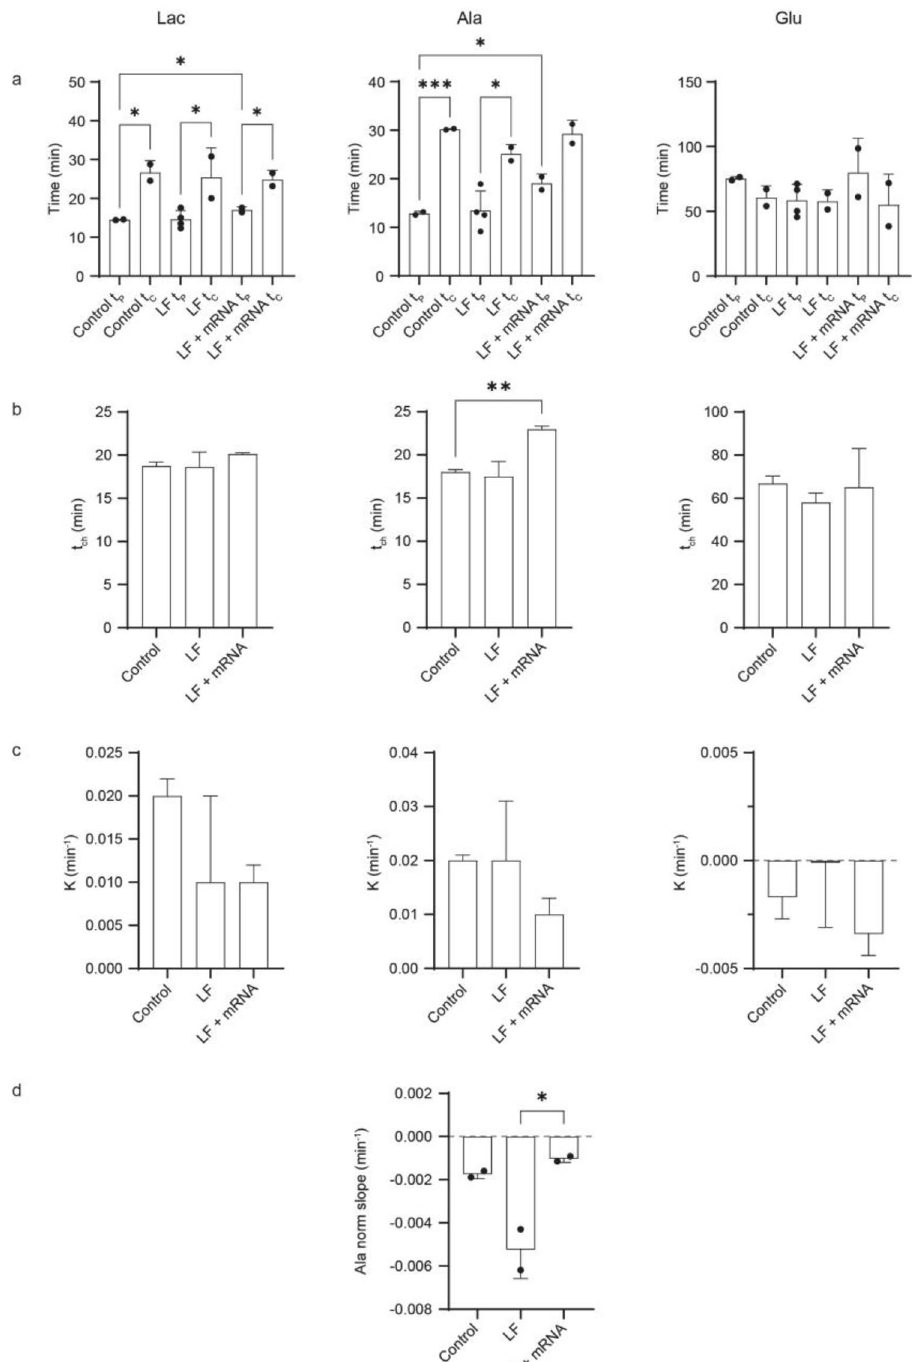
Figure 5. Statistical evaluation of differences between KFP parameters ( a ) production and clearance times, t P and t C ; ( b ) characteristic times, t ch = 2/(1/t P + 1/t C ), ( c ) binding parameters, K = (1/t P —1/t C )/2, for each metabolite, and ( d ) the slopes of alanine KFPs after treatment with LF and LF-mRNA. Dots represent data points obtained using biological replicate samples. Stars indicate significance: p < .05 (*), p < .01 (**), and p < .001